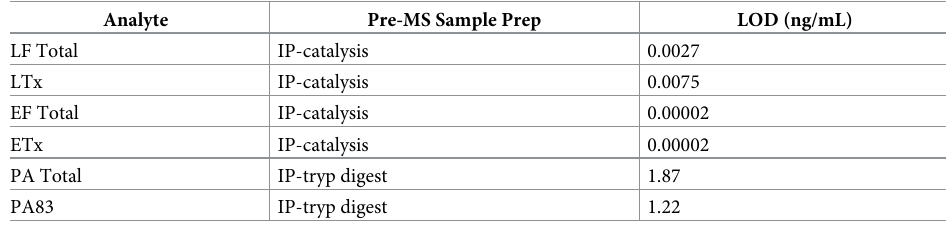
Table 2. Anthrax toxin mass spectrometry (MS) 3-step methods